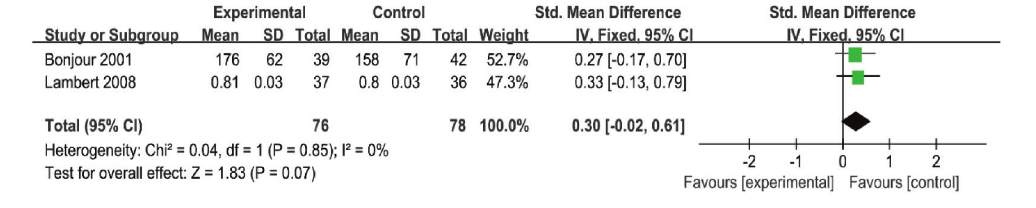
Figure 8. Meta-analysis of the effects of calcium supplements and placebo by random-effects model on the 2nd–4th lumbar vertebrae BMD in healthy